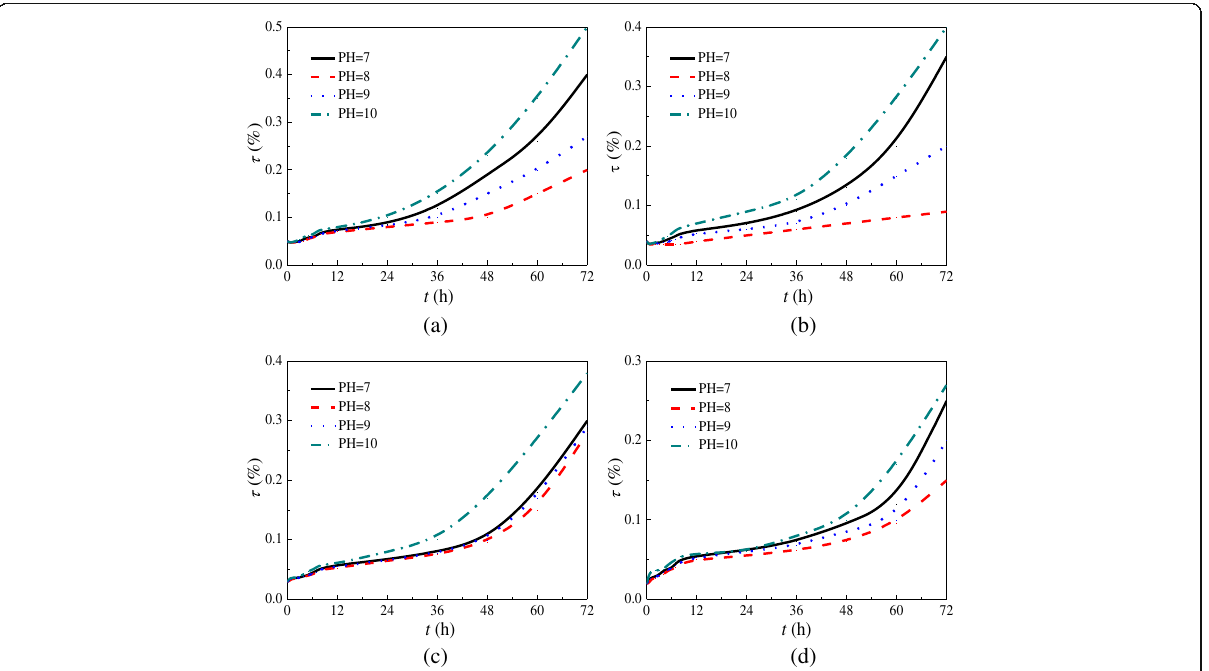
Fig. 4 Transmittance of TiO 2 -water nanofluid. Transmittance ( τ ) changes of TiO 2 -water nanofluid (wt% = 0.5%) under different pH values with times ( h ) at different doses ( m ) of dispersant agent. a m = 5 wt%. b m = 6 wt%. c m = 7 wt%. d m = 8 wt%